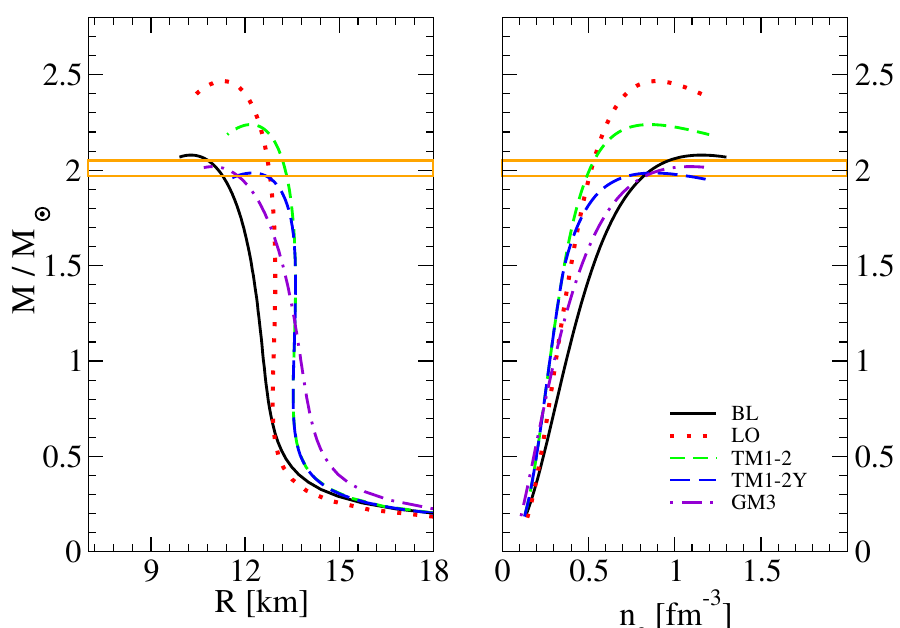
Figure 2. Mass–radius relationship ( left ) and mass–central baryon density relationship ( right ) for the EOS models considered in this work. The strip with boundaries marked with orange lines stands for the measured mass M = 2.01 ± 0.04 M (cid:12) [25] of the neutron stars in PSR J0348 +